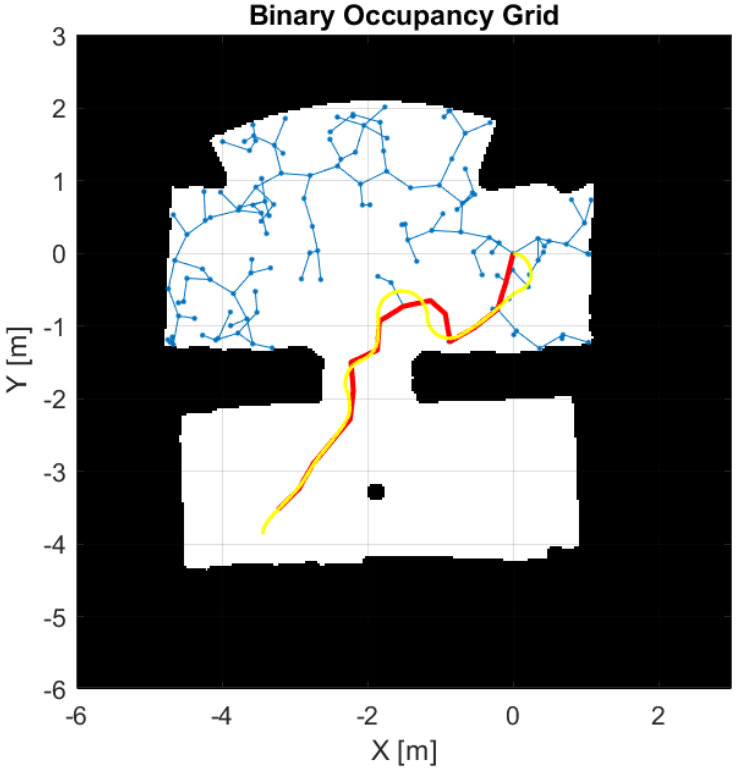
Figure 18. Desired waypoints obtained with RRT algorithm and path obtained from odometry